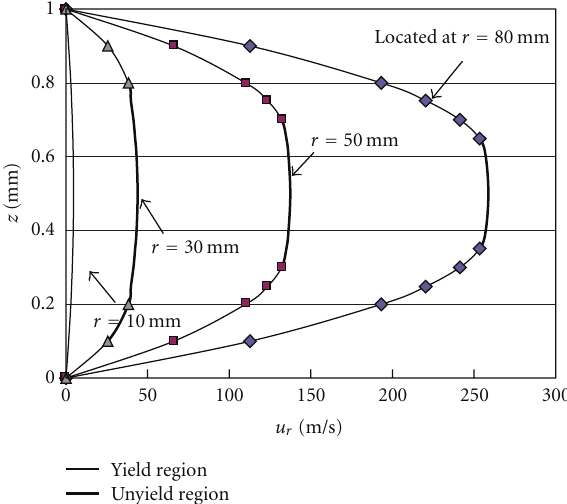
Figure 7: Velocity profiles for di ff erent location of radius.